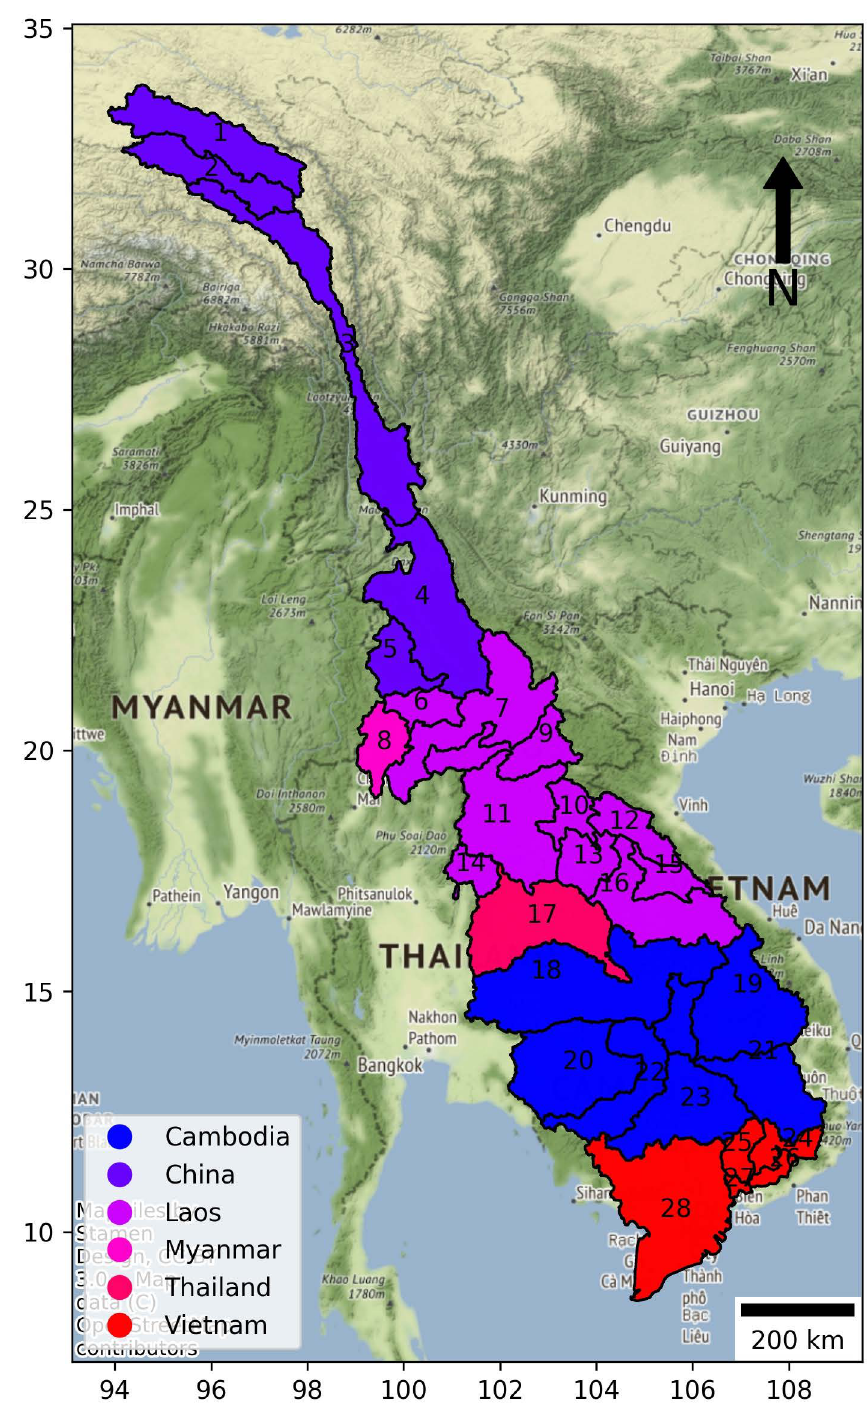
Figure 2. Study area of the Mekong River